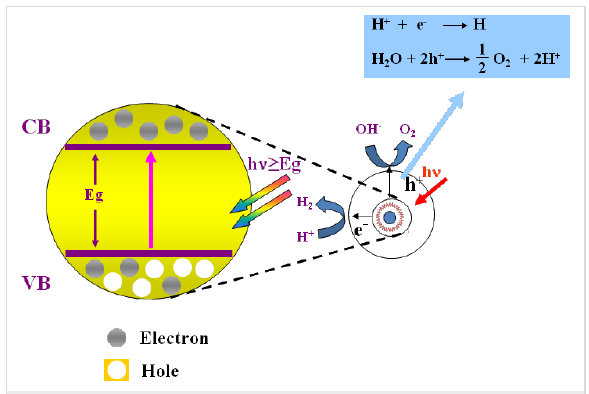
Figure 1: Basic principle for overall water splitting over semiconductor photocatalysts. Reprinted with permission from [6]. Copyright (2010)